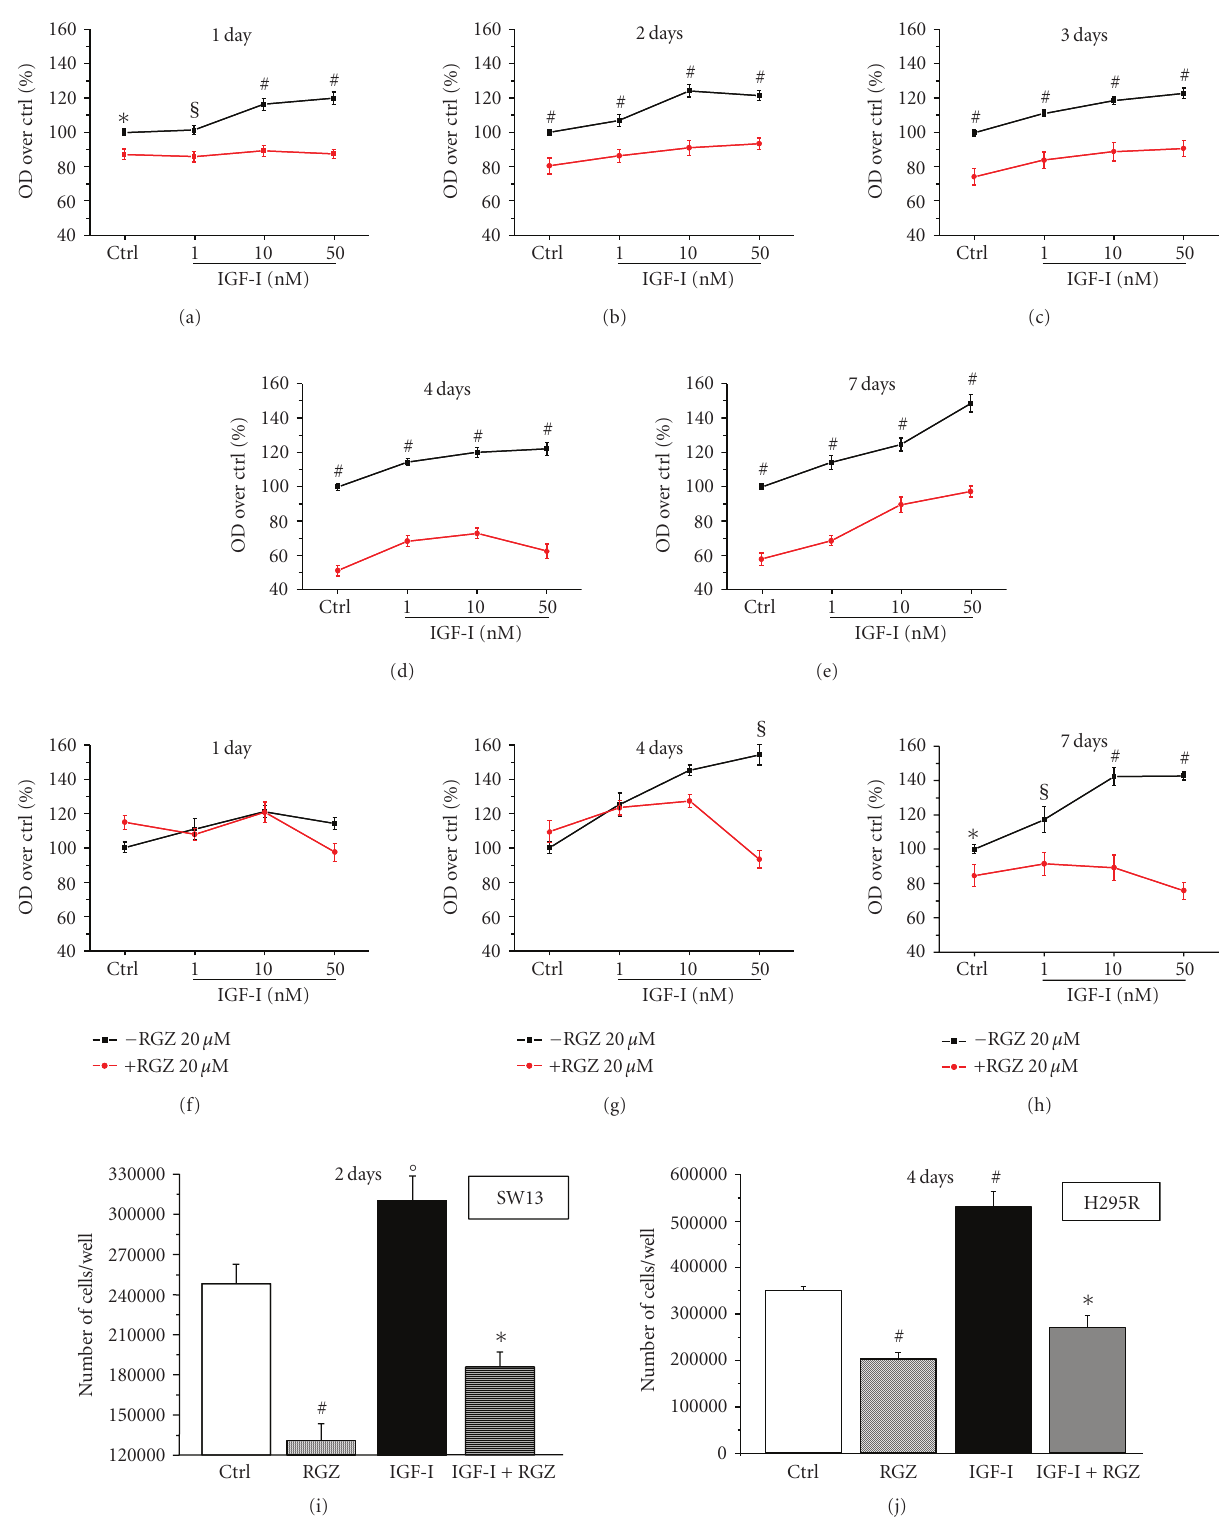
Figure 3: IGF-induced cell proliferation is di ff erently a ff ected by RGZ in SW13 and H295R cell lines . SW13 (a)–(e) and H295R (f)–(h) proliferation was evaluated by MTS assay following stimulation with increasing doses of IGF-I in the presence or absence of 20 μ M RGZ for the indicated times. Mean ± SE percentage of OD over respective control. Statistical significance: ∗ P < 0 . 05, § P < 0 . 005, # P < 0 . 001 versus the corresponding points with RGZ, n = 6. Total number/well of SW13 (i) and H295R (j) cells treated with 10nM IGF-I and 20 μ M RGZ for 2 and 4 days, respectively, was evaluated by cell counting under optical microscope. Data are expressed as mean ± SE of cell number evaluated in triplicate in three independent experiments. ◦ P < . 01, # P < . 001 versus Ctrl; ∗ P < . 001 versus